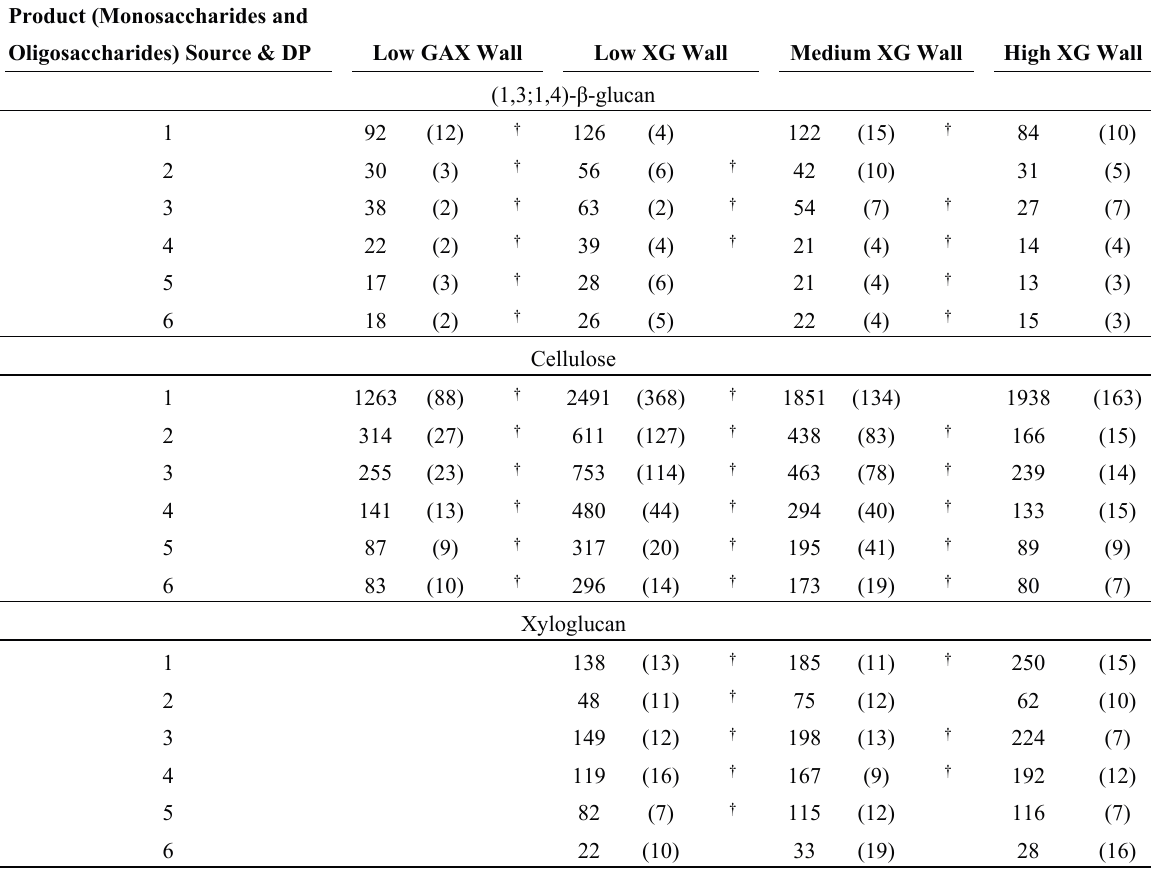
Table 1. Break down products (monosaccharides and oligosaccharides) and their polysaccharide origin over the entire simulation for each of the model wall types, showing mean values followed by standard deviation in parentheses. A dagger ( † ) in a row between two columns indicates a significant difference (based on t -tests) at the 5% level between the corresponding entries in that row. Comparisons were made only between adjacent columns: Low GAX vs. Low XG; Low vs. Medium XG; Medium vs. High XG. Product (Monosaccharides and